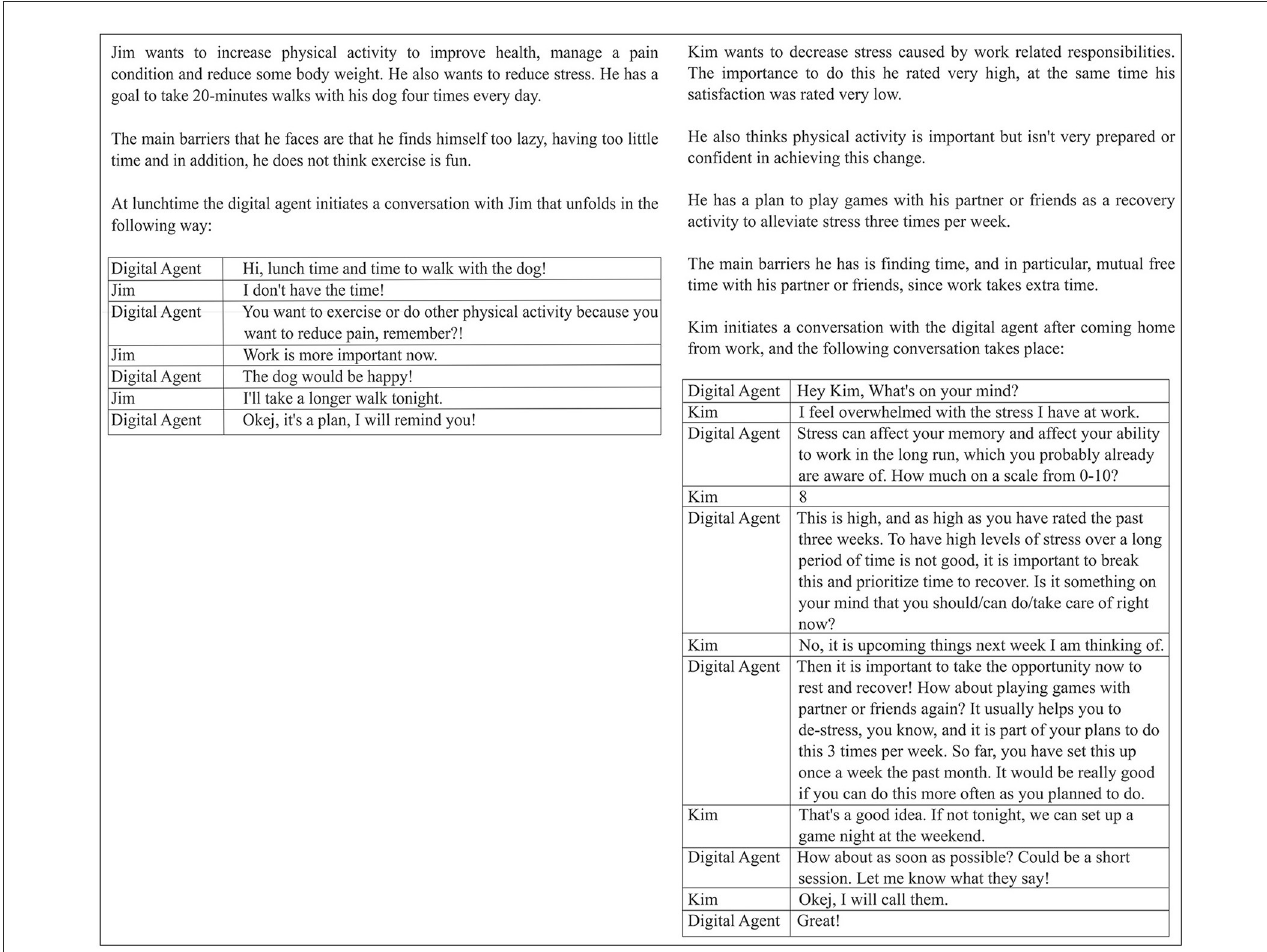
FIGURE2 Example of two scenarios: Jim having a short dialogue at lunchtime (1b), and Kim initiating a dialogue at dinner time (2a).